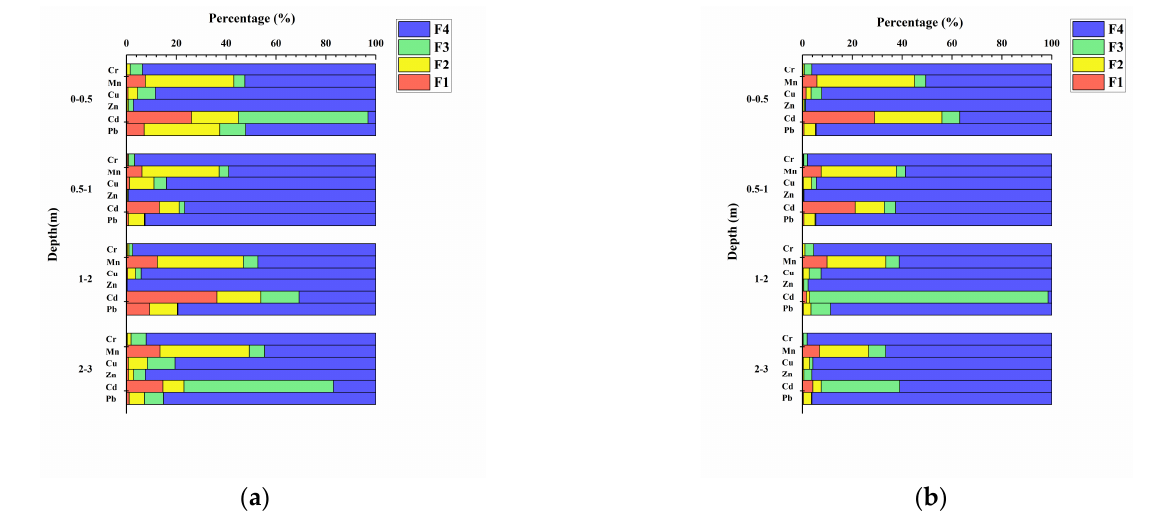
Figure 4. Distribution of HM forms in the vertical direction, ( a ) #1–7; ( b ) #1–12.